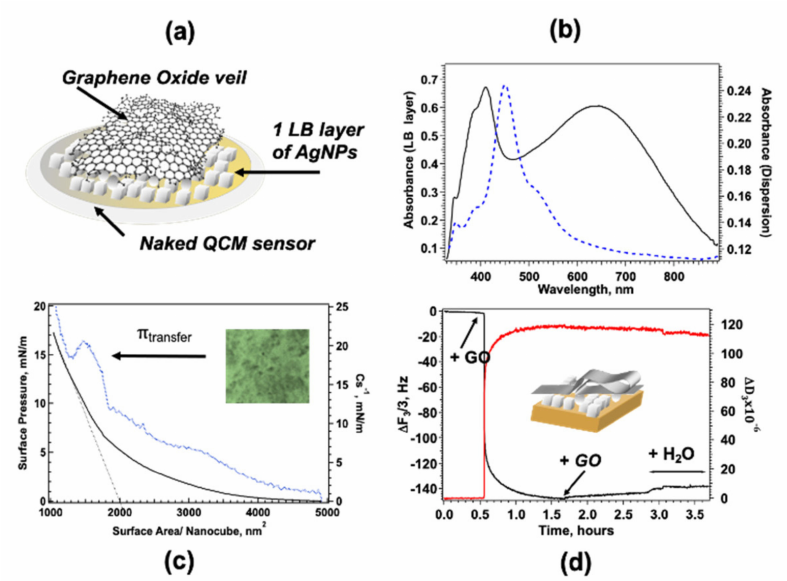
Figure 1. ( a ) Cartoon of the layered GO-AgNC/NS structure built on the QCM sensor. ( b ) Absorption spectra of AgNC/NS dispersion (blue dashed line) and of 1 LB layer of AgNC/NS transferred at 15 mN/m (black solid line). ( c ) Surface pressure-area C s − 1 -A isotherm for a monolayer of AgNC/NS at water-air interface; inset: optical microscopy image in reflection mode of a single AgNC/NS monolayer. ( d ) GO adsorption on AgNC/NS monitored by